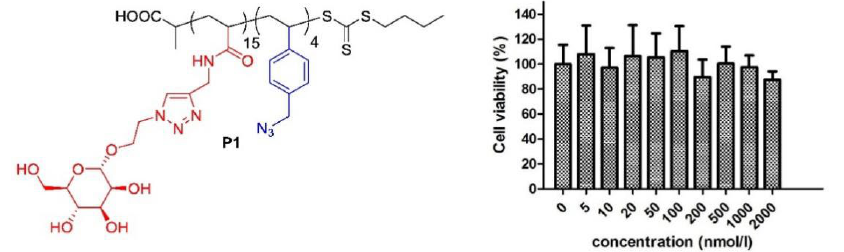
Figure 4. HepG2 cell viability against copolymer P1 (CCK-8 assay, 48 h).